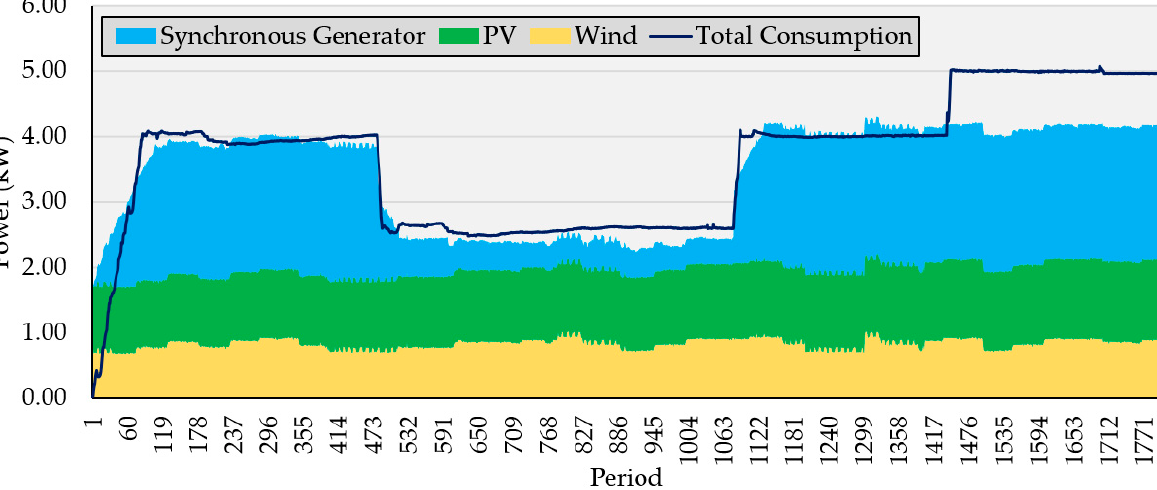
Figure 7. Irrigation system consumption breakdown by generation source.